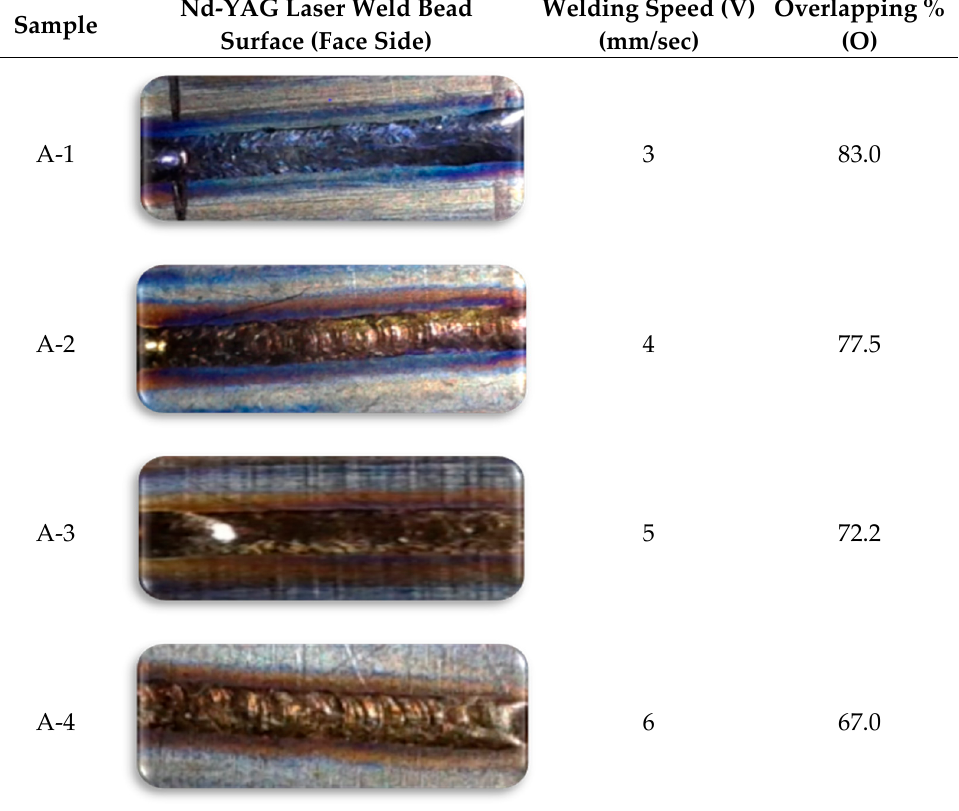
speeds with a magnification scale of 50 ×